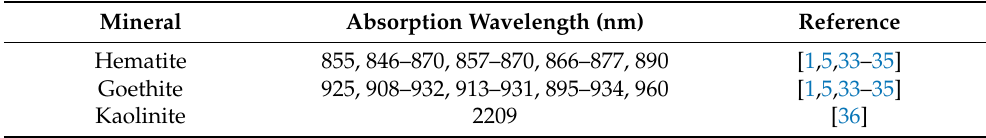
Table 3. Wavelength positions of hematite, goethite and kaolinite established from a number of different studies. It is important to note that some differences are due to differing spectral regions used in continuum corrected spectra. The hematite and goethite absorption wavelengths presented are adapted from Table I of